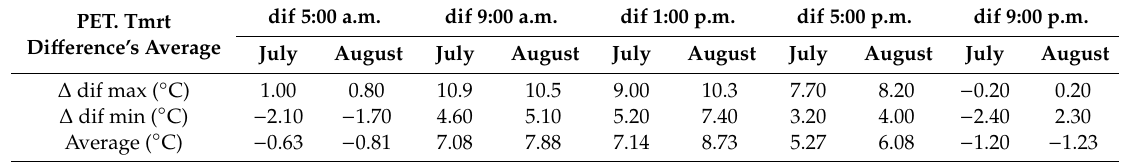
Table 6. Di ff erence values between PET and Tmrt between July and August 2018. PET.